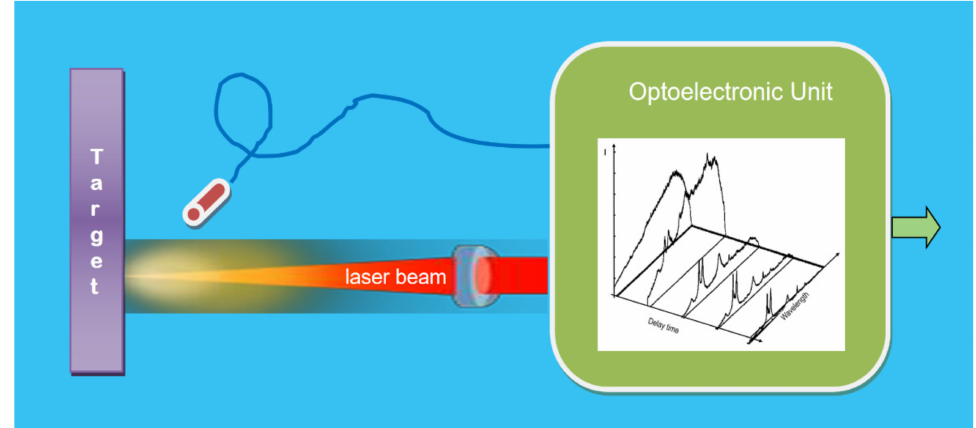
Figure 14. Schematic illustration of PS based on laser spectroscopy to detect and quantify chemical elements of materials (in solid, liquid or gas states). After interacting with the target, focused pulsed laser beams generate plasmas (including a stoichiometric ions concentration, Mx, of target material). The Light emitted by the plasma induced by the laser pulse is appropriately captured in an appropriate delay time (inaccurate synchronism with the laser pulse). Their spectra are obtained in the optoelectronic unit. After detection and properly processing, the information with the chemical elements concentration (and their quantification) is offered at the output of OU. Courtesy of the